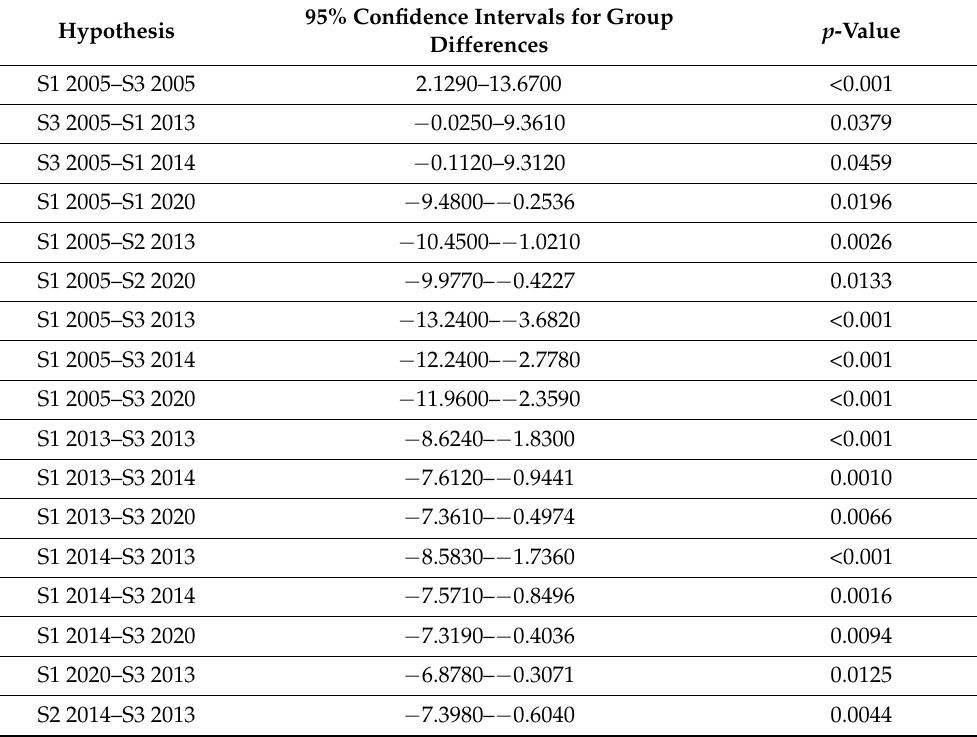
Table 3. Statistically significant differences from ANOVA analysis of viable seeds data. p < 0.05.